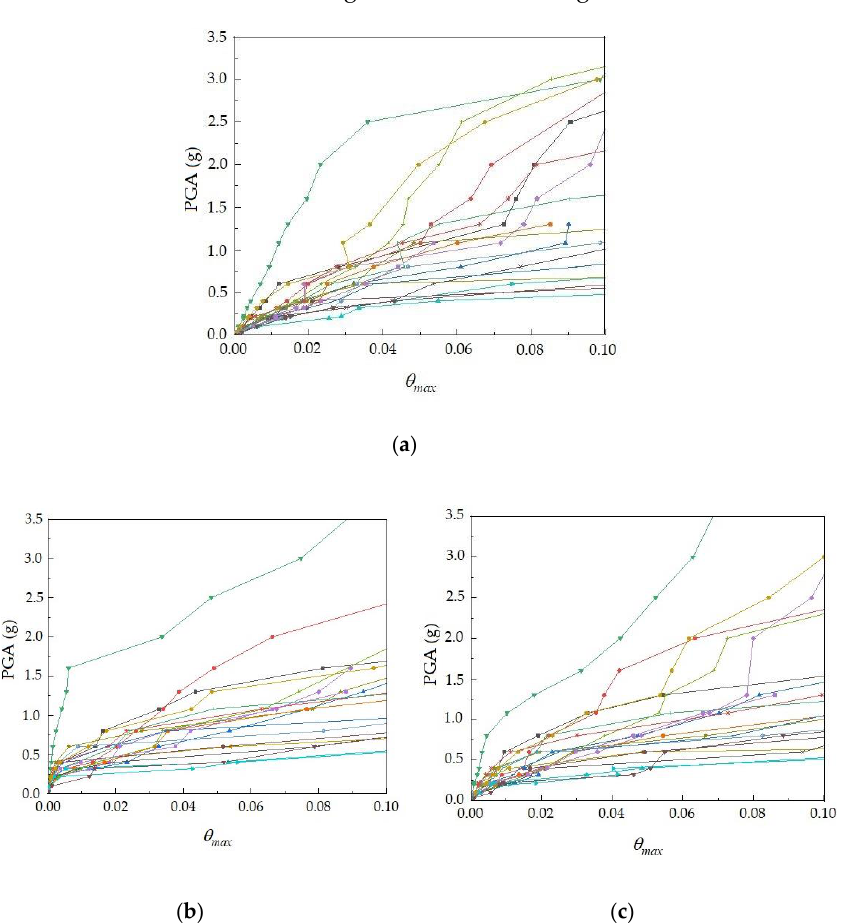
Figure 8. The IDA curves of 20 pairs of ground motions for ( a ) Model F6-6; ( b ) Model IF6-6; ( c ) Model IFE6-6.